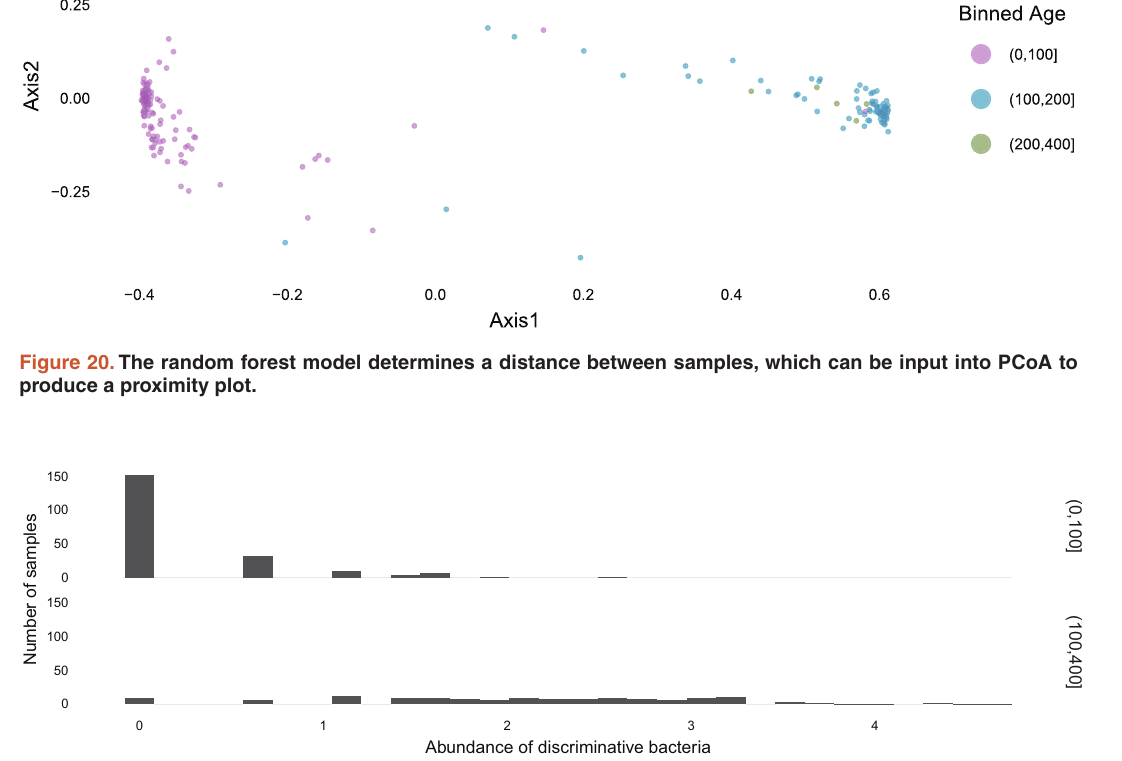
Figure 21. A bacteria in genus Roseburia becomes much more abundant in the 100 to 400 day